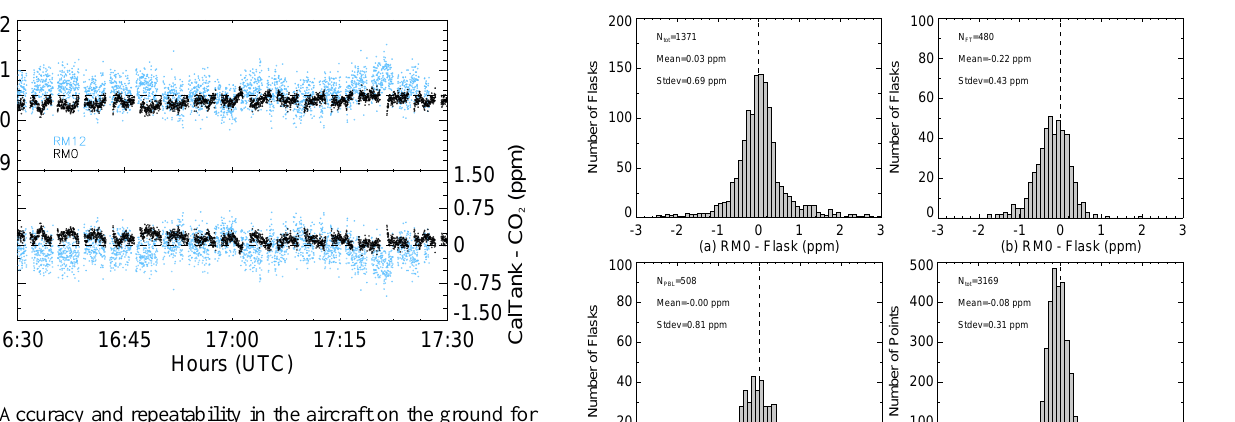
Fig. 5. Accuracy and repeatability in the aircraft on the ground for the two continuous CO 2 systems (black=RM0 and blue=RM12) estimated from the measurement of CO 2 mole fraction delivered by a cylinder maintained at ambient pressure and flushed continuously by a stream of reference gas calibrated earlier in the laboratory. Re- peatability for RM0 and RM12 as shown on top panel was 0.10ppm (standard deviation of N = 2814 observations) and 0.25ppm (stan- dard deviation of N = 2937 observations), respectively. Accuracy as shown on bottom panel, including the specific mission calibra- tion and accuracy of delivery of reference gas, was 0.13ppm and − 0.06ppm for RM0 and RM12, respectively.